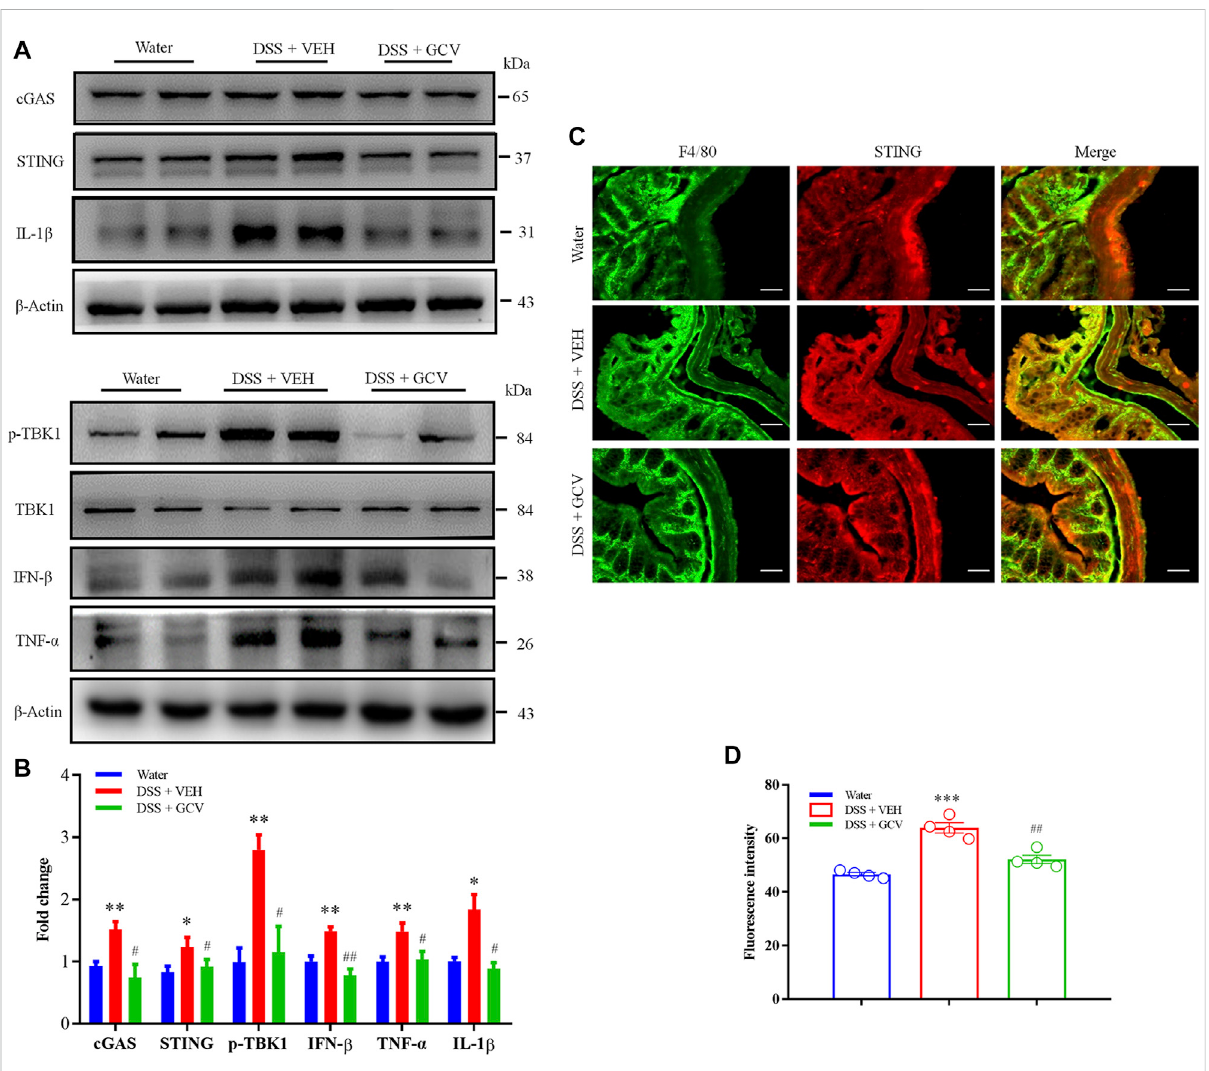
FIGURE 6 Low-dose GCV attenuated cGAS-STING pathways in the colon of DSS-colitis in mice. (A) Western blotting analysis showed that protein expression of colonic STING, cGAS, p-TBK1, IFN- β , IL-1 β , and TNF- α in mice of different treatment group. (B) Statistical analysis for (A) ( n = 4 per group, * p < 0.05, ** p < 0.01, DSS vs. vehicle group; # p < 0.05, ## p < 0.01, ### p < 0.001, GCV + DSS vs. DSS group; unpaired Student ’ s t -test). (C) DoubleimmunostainingofSTINGandF4/80inthecolontissue. (D) Statisticalresultsfor (C) .Scalebar=50 μ m.( n =4eachgroup,*** p <